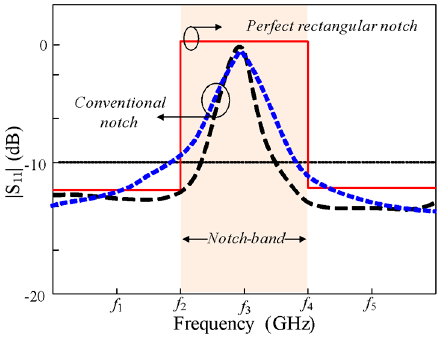
Figure 1. Conventional notch and the rectangular notch .